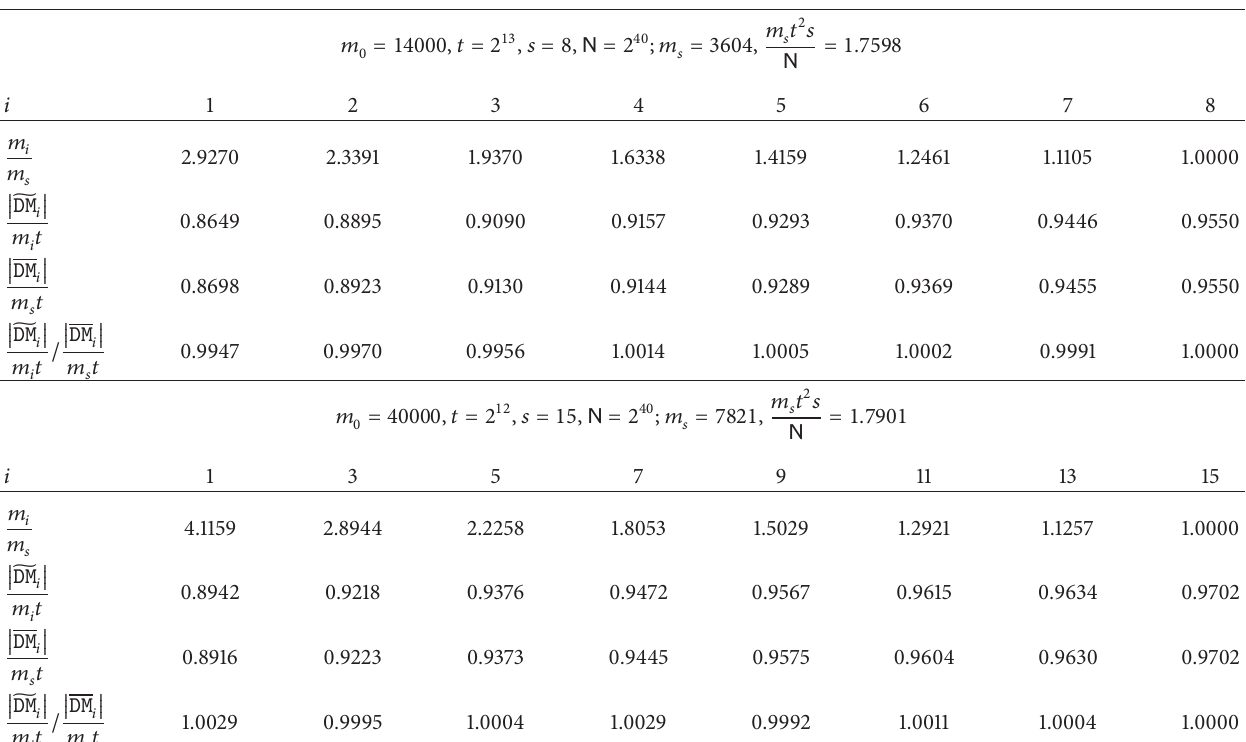
Table 2: Experimental confirmation that selection of DM 𝑖 from ̃ DM 𝑖 does not disturb average chain length.